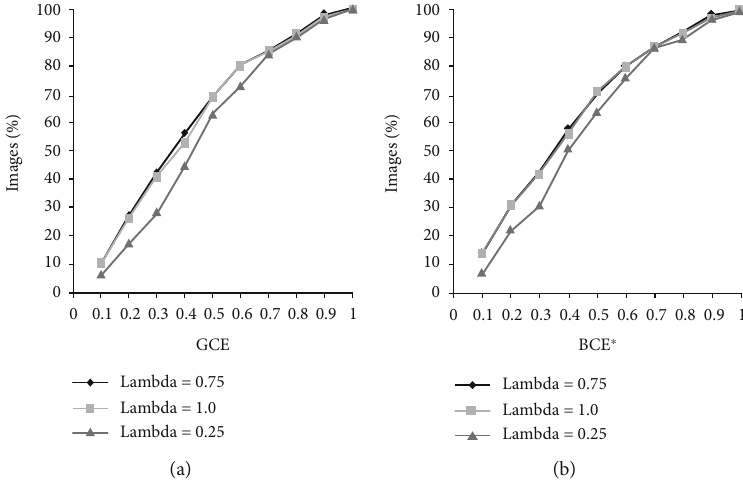
Figure 2: Error metrics for di ff erent values of λ for 100